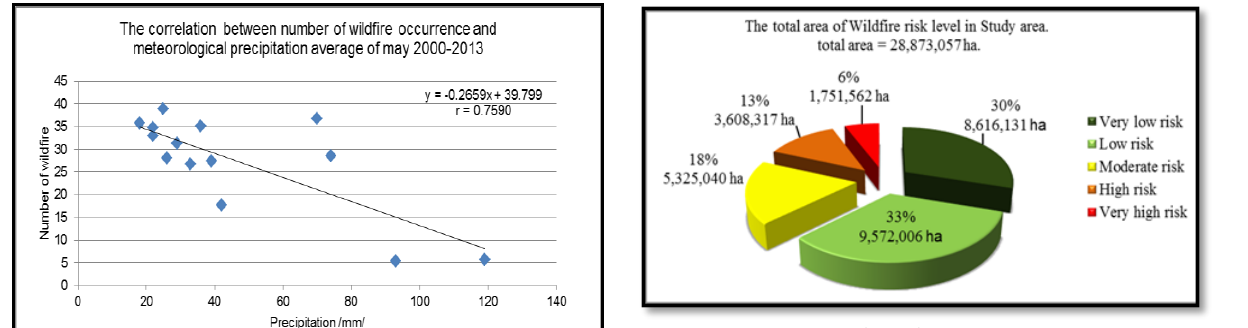
Figure 9. Result of wildfire risk level in Study area